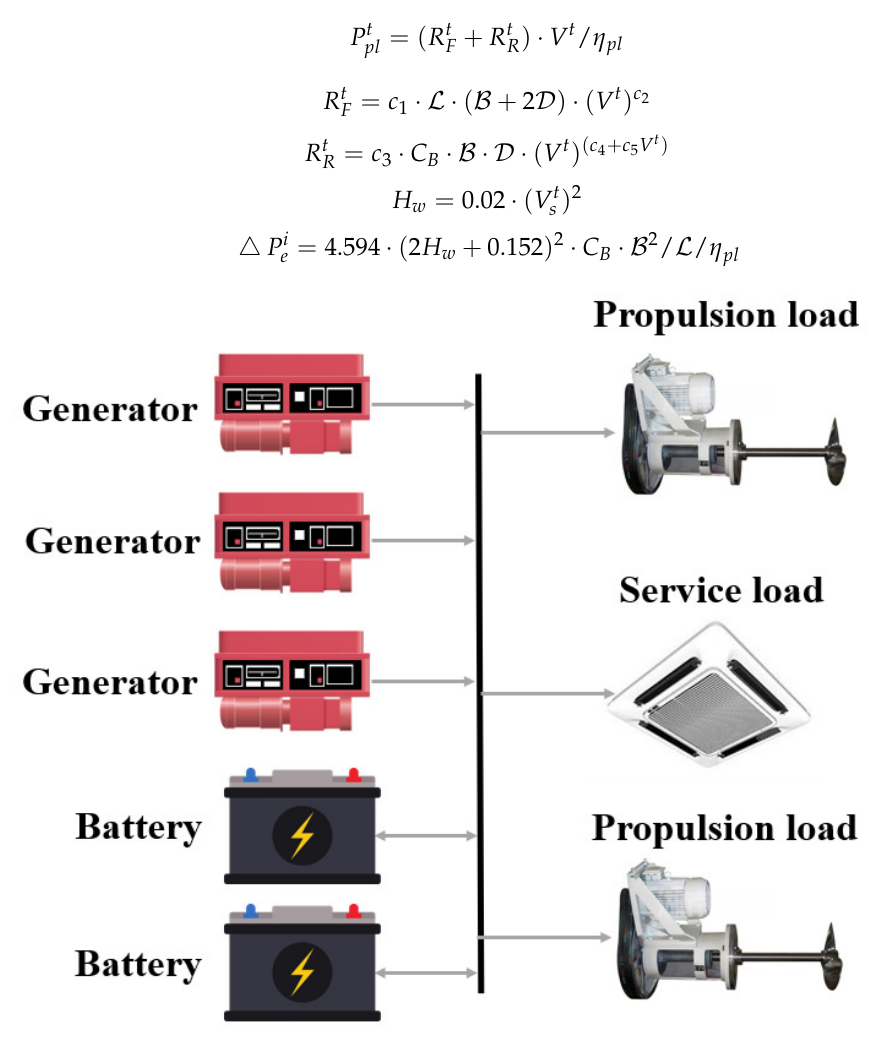
Figure 1. Topology of tugboat power